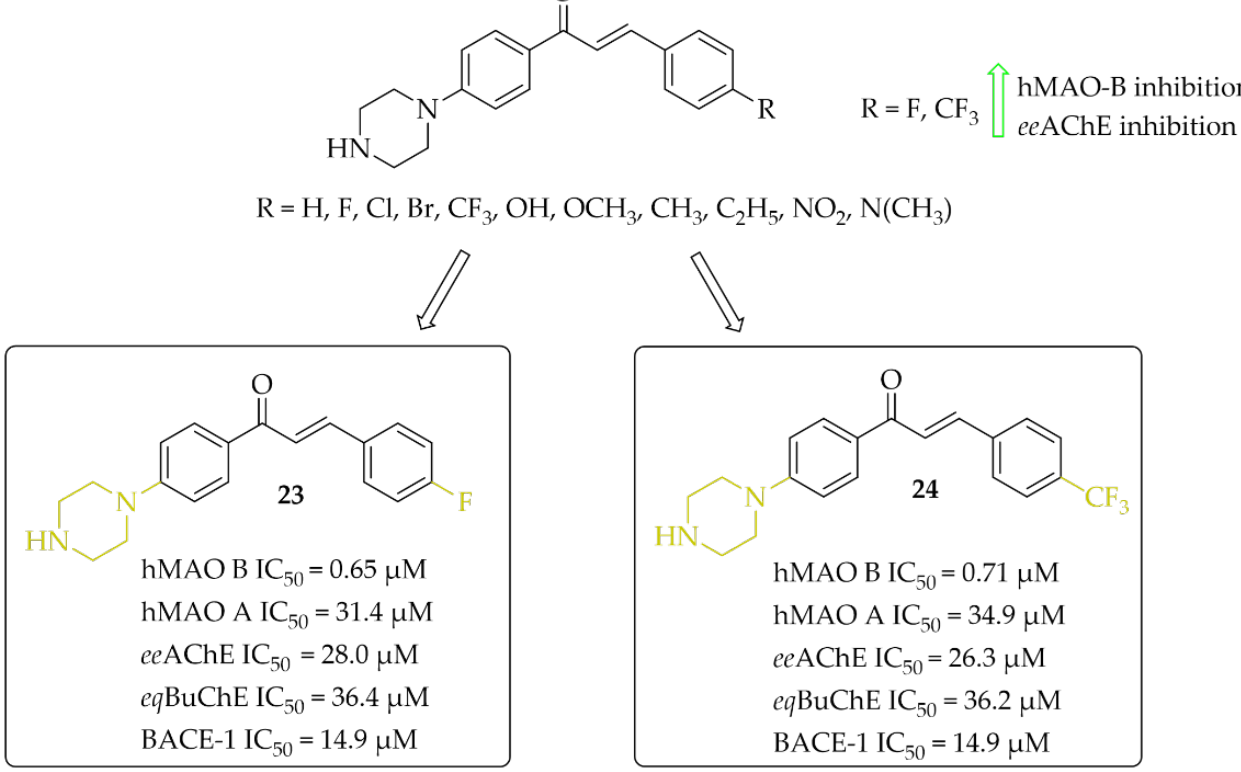
Figure 18. Piperazine-based chalcones as multitarget inhibitors and the most potent compounds in this series [44].